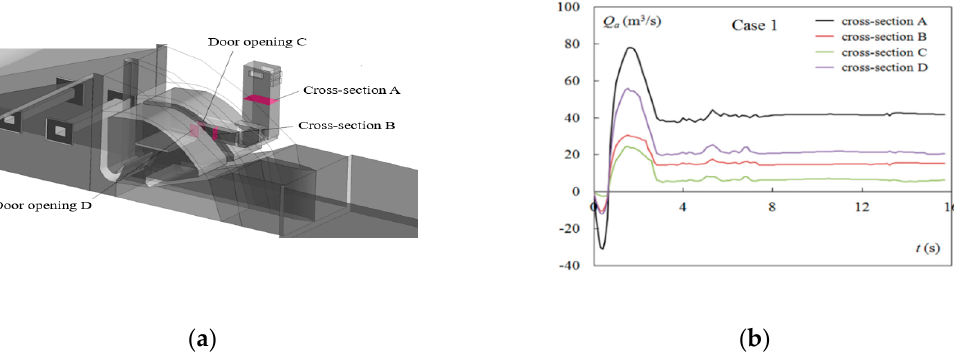
Figure 10. ( a ) Cross-sections A, B, C and D; ( b ) simulated Q a values in Case 1. Table 2. Case 1, averaged Q a and V a values at sections A, B, C and D. Cross-Section